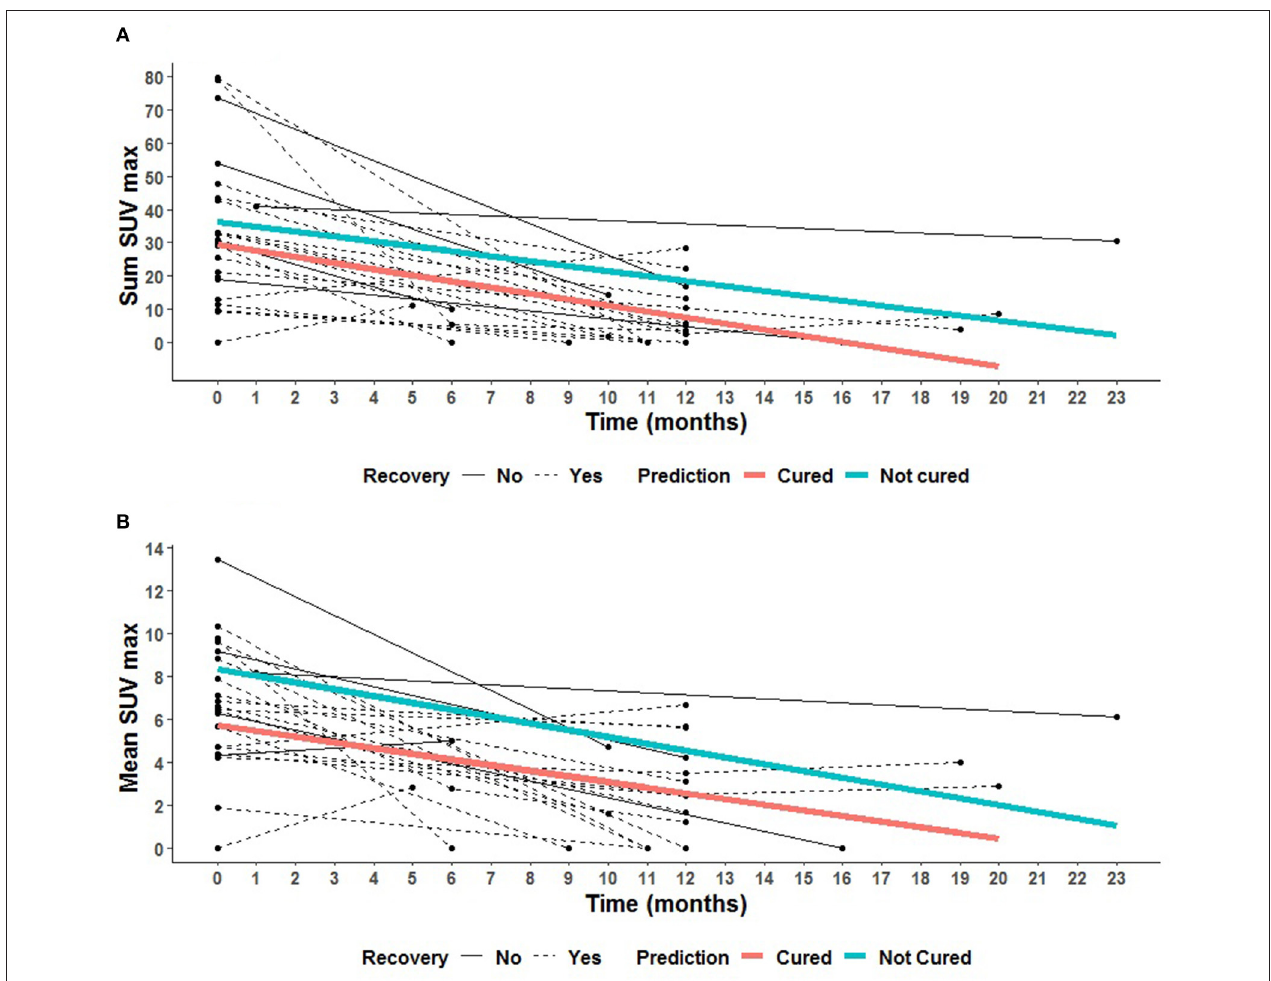
FIGURE 2 | Spaghetti plots of the 23 patients with final diagnosis at the end of treatment. Description of the evolution of the PET parameters with time for each patient, for cured patients (black dotted line) at the end of treatment (red slope, mean prediction), and for uncured patients (black solid line) at the end of treatment (blue slope, mean prediction). (A) Description of the evolution of Σ SUV for each patient. (B) Description of the evolution of MSUV for each